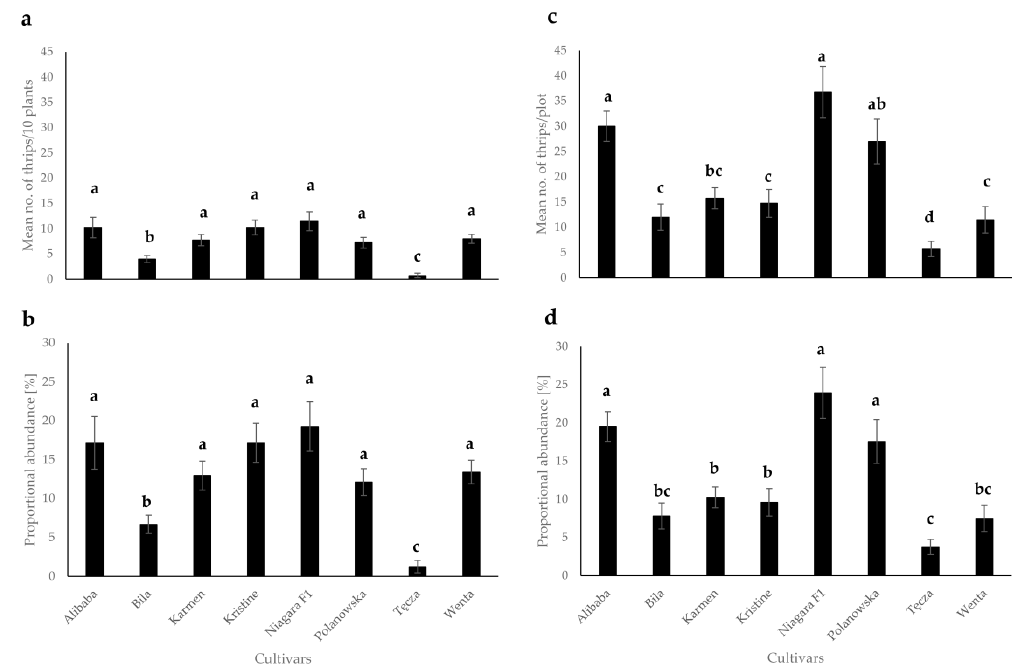
Figure 4. Actual count (mean ± SE) and proportional abundance of Thrips tabaci adults collected ( a , b ) directly from plants and ( c , d ) with sweep net during onion plant colonization by thrips in 2016. Means with the same letters on each bar are not significantly different (Duncan’s Multiple Range Test p < 0.05).